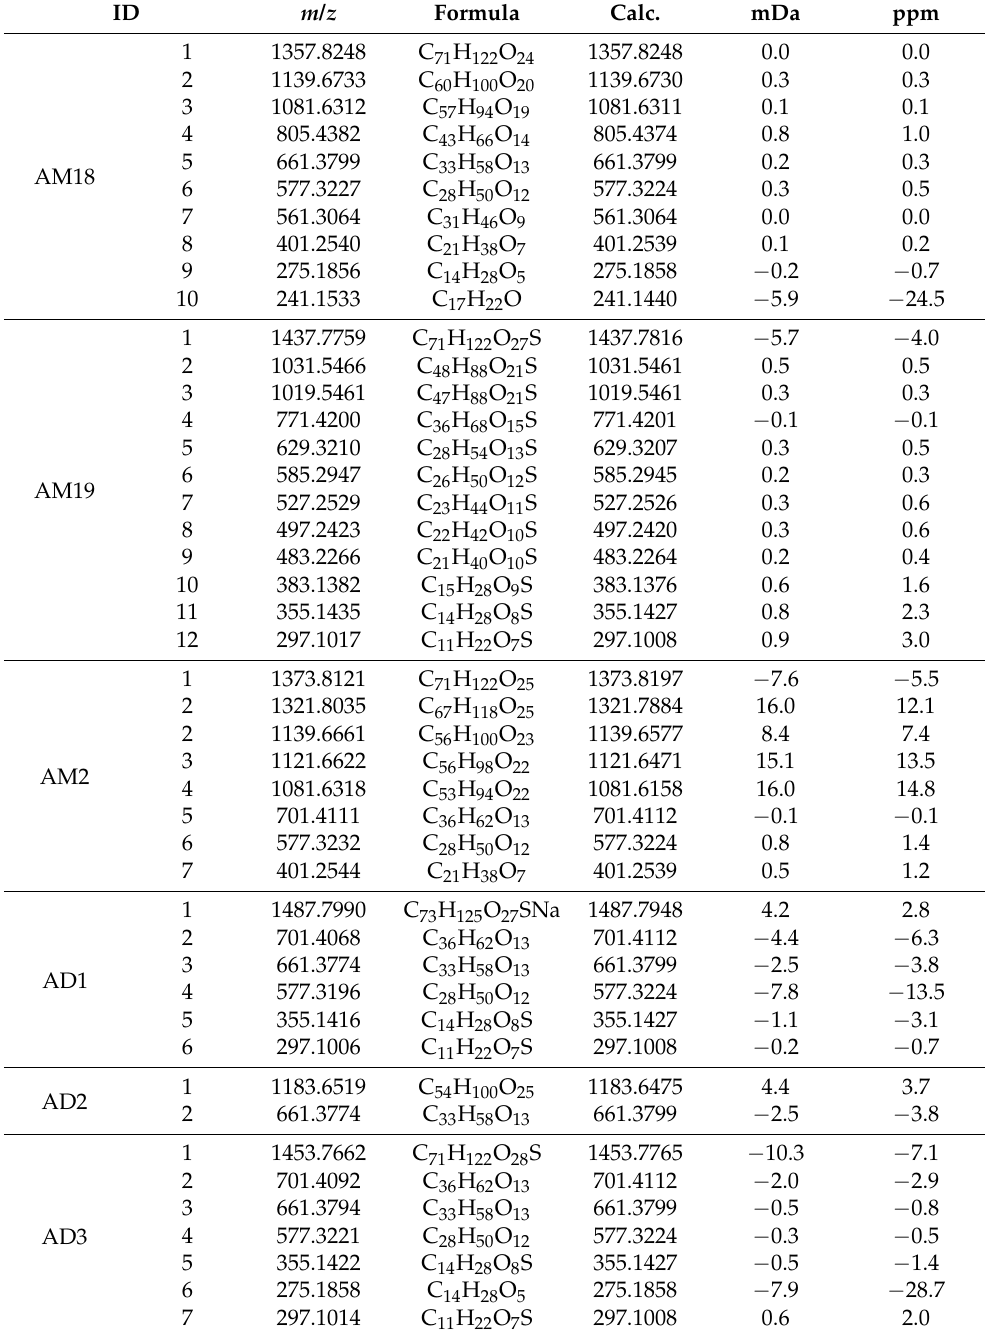
Table 1. Exact masses, elemental composition, and error between empirical and theoretical masses of AMs.